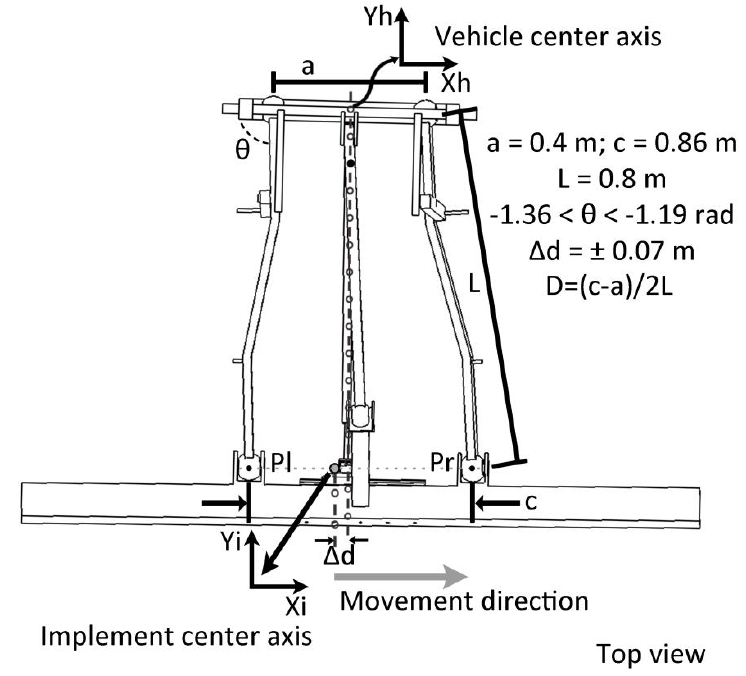
Figure 9. Schematic model of the three-point hitch for connecting the